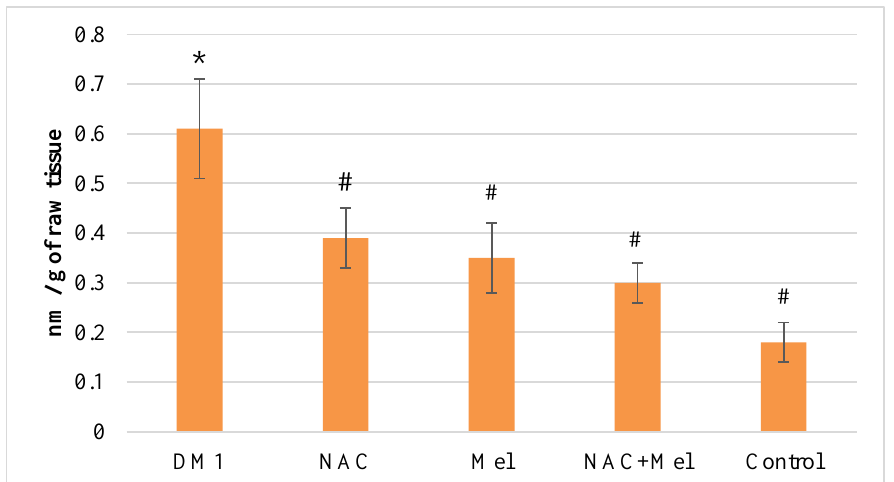
Fig. 2. Changes in the level of 8-oxoG in brain cells of diabetic rats that received a physiological solution and drugs. DM 1 (rats with diabetes mellitus 1 receiving physiological saline per os); NAC (rats with DM 1, administered NAC at a dose of 1.5 g/kg per os); Mel (rats with DM 1 receiving Mel in a dose of 10 mg/kg per os); NAC+Mel (diabetic rats receiving NAC and Mel per os in combination therapy); control (intact rats). NAC / Mel or NAC+Mel were administered within 5 weeks. * in comparison with control, p<0.01; # in comparison with DM 1,